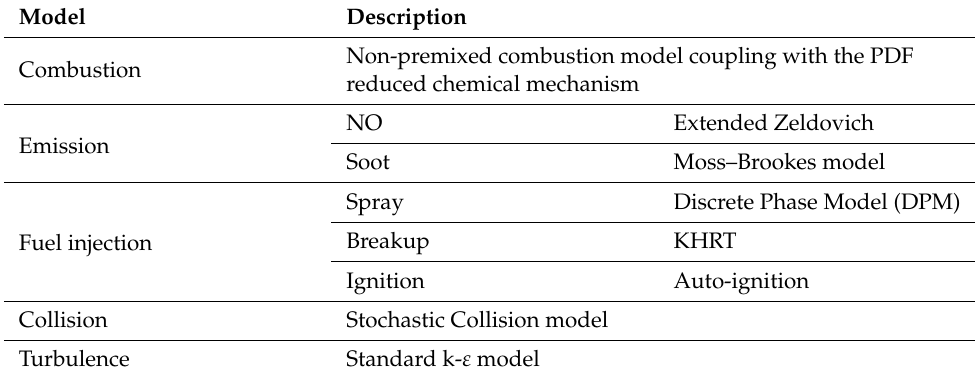
Table 5. Summary of the CFD models.